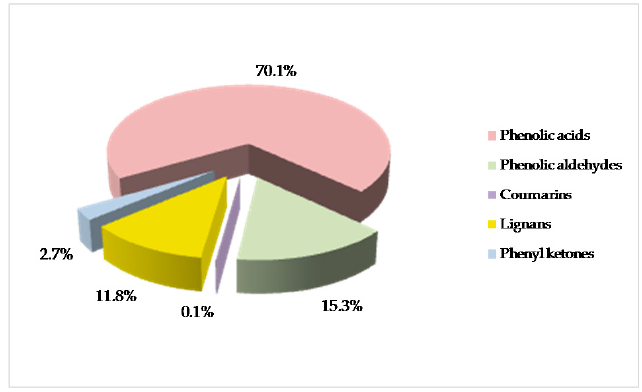
Figure 1. Relative importance of some phenolic classes in the aged wine spirits.